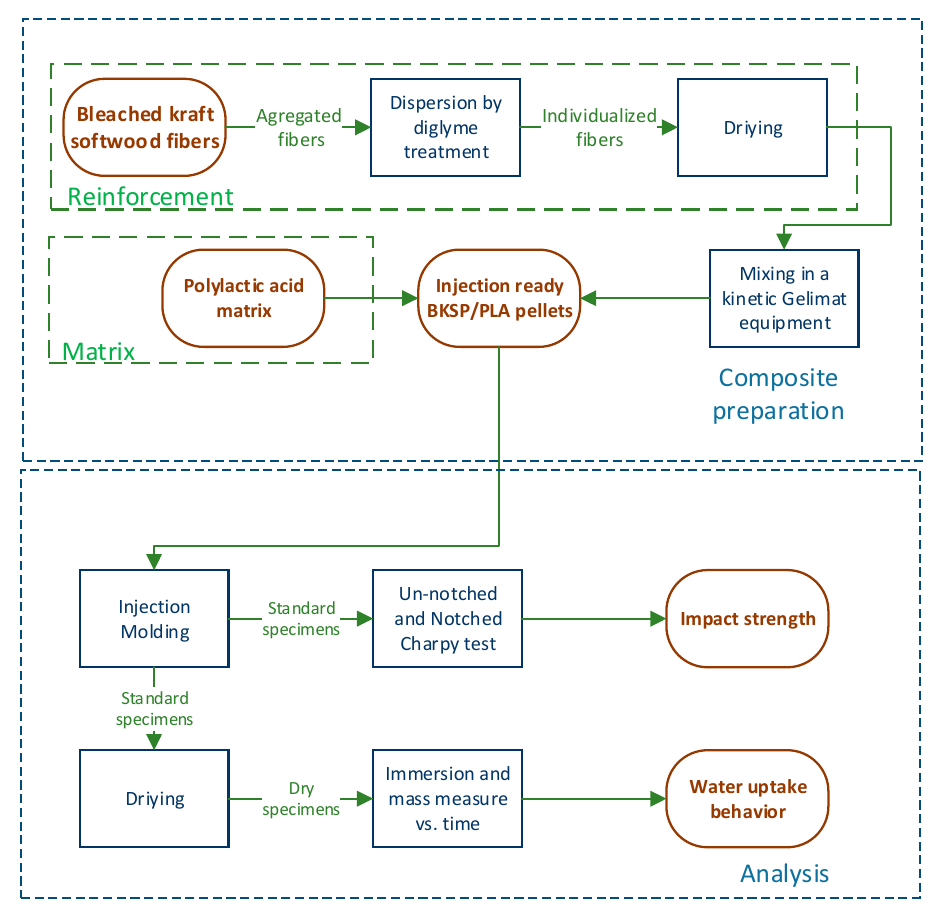
Figure 1. Schematic procedure of the proposed research.